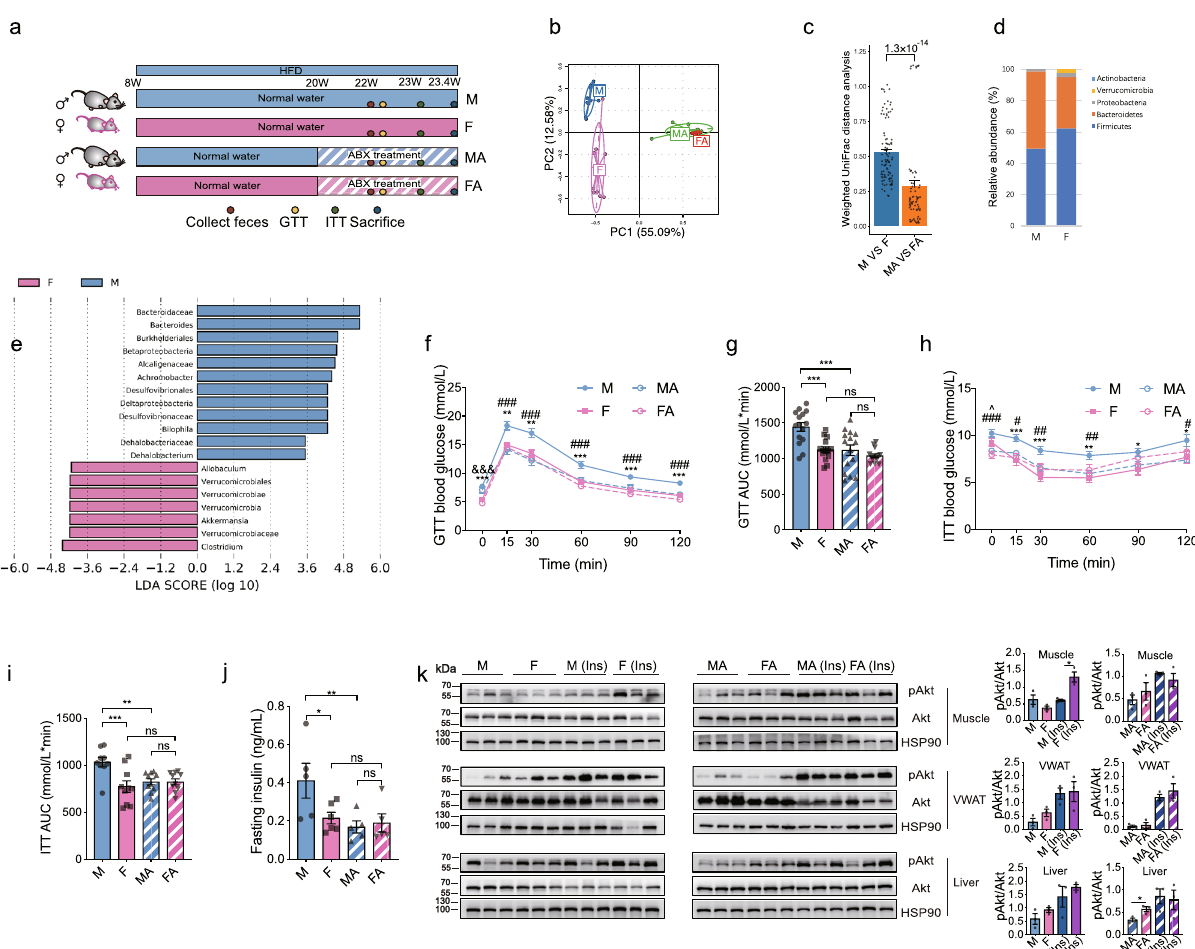
Fig. 2 Gut microbiome depletion abolishes sex-biased glucose metabolism in mice fed high-fat diet (HFD). a Schematic diagram of male and female mice with or without ABX treatment. b PCA of the gut microbiome based on the OTUs of the indicated groups (mice, n = 10 for M and F; n = 9 for MA; n = 8 for FA). c Weighted UniFrac distance analysis of the gut microbiome in the indicated groups (mice, n = 10 for M and F; n = 9 for MA; n = 8 for FA). d The relative abundance of the fi ve most abundant microbial phyla in male and female mice (mice, n = 10 for M and F; n = 9 for MA; n = 8 for FA). e LDA of the gut microbiome between male and female mice. LDA scores were used to estimate the contribution of the abundance of each taxon to the differences between the groups. For the positive LDA score in log 10 in blue bar presents the genera enriched in male mice, while the negative LDA score in log 10 in red bar presents genera enriched in female mice. Taxa with an LDA score (log 10 ) >2.0 or < − 2.0 are shown (mice, n = 10 for M and F; n = 9 for MA; n = 8 for FA). f , g GTT ( f ) (for M VS F, P = 2.2 × 10 − 5 and for MA VS FA, P = 3.3 × 10 − 5 at 0 min; for M VS F, P = 0.001 and for M VS MA, P = 1.3 × 10 − 4 at 15 min; for M VS F, P = 0.001 and for M VS MA, P = 2.8 × 10 − 5 at 30 min; for M VS F, P = 9.5 × 10 − 5 and for M VS MA, P = 2.4 × 10 − 4 at 60 min; for M VS F, P = 7.2 × 10 − 5 and for M VS MA, P = 5.6 × 10 − 4 at 90 min; for M VS F, P = 5.6 × 10 − 6 and M VS MA, P = 1.9 × 10 − 5 at 120 min) and the corresponding AUC ( g ) (for M VS F, P = 8.3 × 10 − 5 and M VS MA, P = 5.9 × 10 − 5 ) of the indicated groups (mice, n = 15 for M, F, and MA; n = 14 for FA). h , i ITT ( h ) (for M VS F, P = 0.068, for M VS MA, P = 9.7 × 10 − 4 , and for F VS FA, P = 0.014 at 0 min; M VS F, P = 4.3 × 10 − 4 and for M VS MA, P = 0.014 at 15 min; for M VS F, P = 1.5 × 10 − 4 and for M VS MA, P = 0.009 at 30 min; for M VS F, P = 0.002 and for M VS MA, P = 0.009 at 60 min; for M VS F, P = 0.017 at 90 min; for M VS F, P = 0.032 and for M VS MA, P = 0.012 at 120 min) and the corresponding AUC ( i ) (for M VS F, P = 3.2 × 10 − 4 and for M VS MA, P = 0.003) of the indicated groups (mice, n = 9 for M; n = 10 for F, MA, and FA). For f and h , M vs F, * P < 0.05, ** P < 0.01, *** P < 0.001; MA vs FA, &&& P < 0.001; M vs MA, # P < 0.05, ## P < 0.01, ### P < 0.001; F vs FA, ^ P < 0.05. j Six-h fasting plasma insulin levels (for M VS F, P = 0.018 and for M VS MA, P = 0.006) (mice, n = 5 for M, n = 6 for F; n = 5 for MA and FA). k Left, representative western blotting of total and pAkt in muscles, VWAT, and the